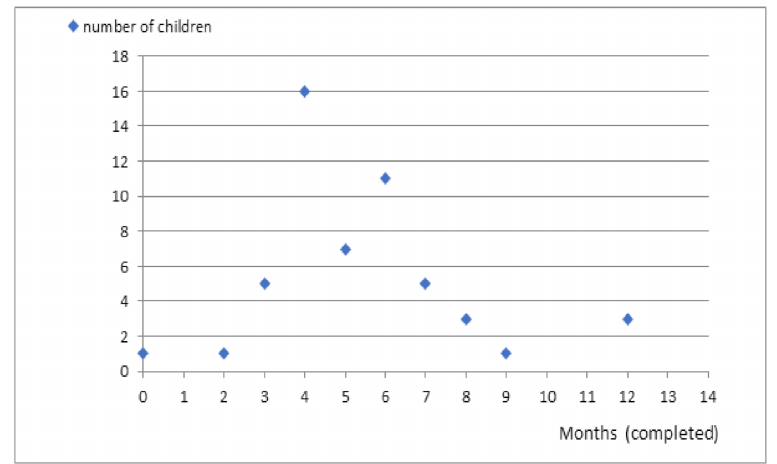
Figure 1. Time of the first